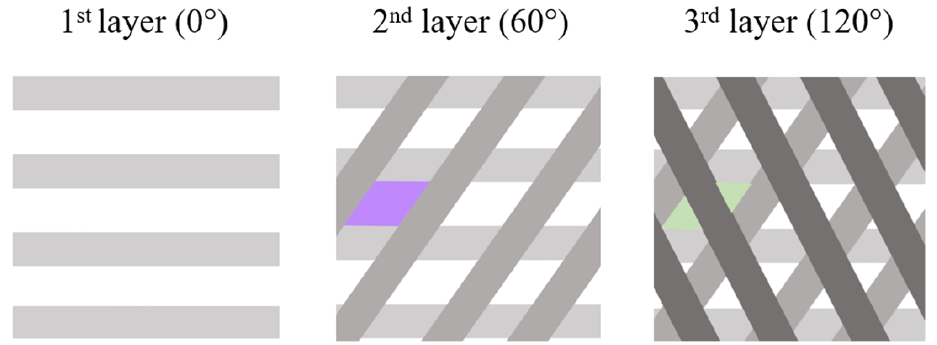
Figure 4 . Schematic representation of the layer deposition until layer 3. A diamond shape is highlighted in purple in the 2nd layer, and the resulting triangles are highlighted in green in the 3rd one.